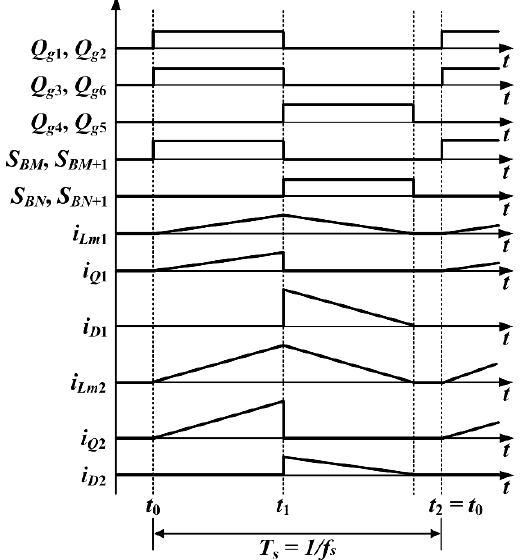
Figure 4. Operation waveforms of proposed active balancing circuit for pack-to-odd cell and even cell-to-pack operations.